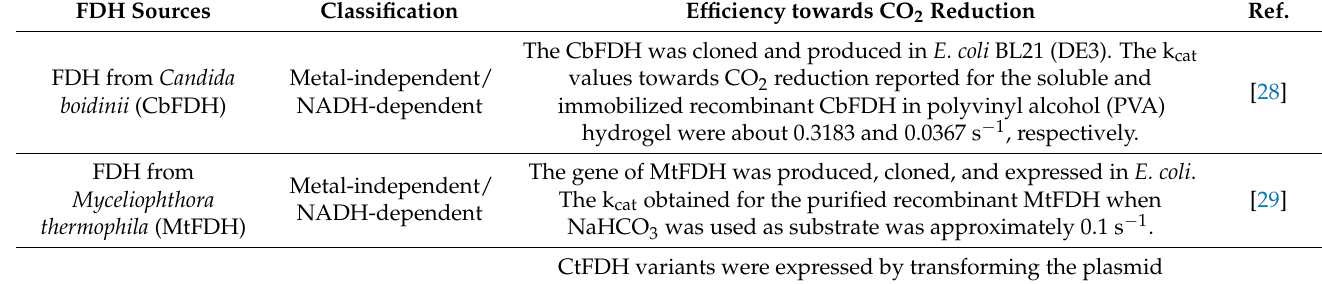
Table 1. FDH from different bacterial sources reported to be able to uptake CO 2 directly. Efficiency towards CO 2